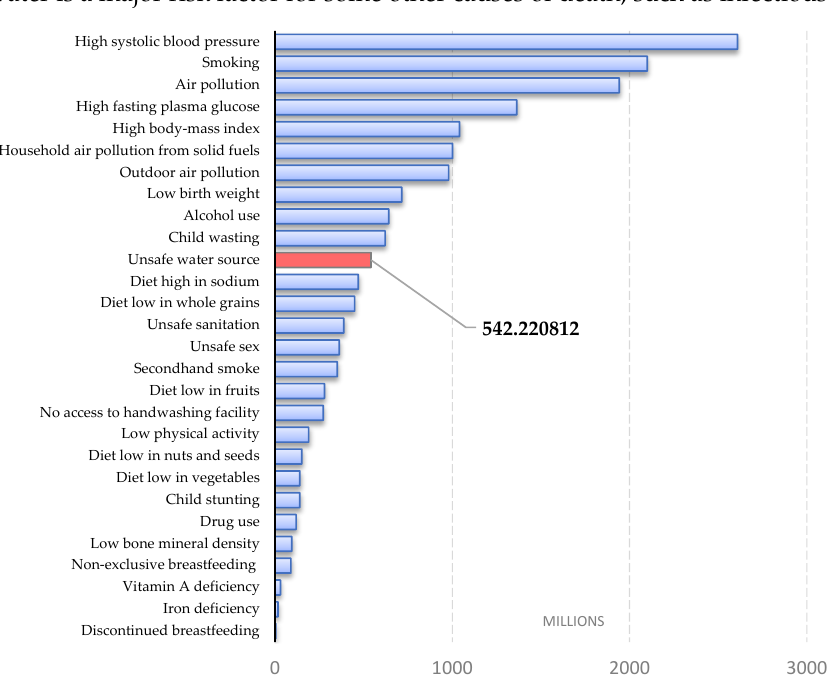
Figure 2. The relation between SDGs and maintaining drinking water quality [16–19]. Threats concerning water quality are divided into physical, chemical, and biological. Studies show that the damage caused by the last two cases is far more severe [20]. Indus- trial wastewater contains several toxic contaminants, such as pesticides, heavy metals, and pharmaceuticals. Among these pollutants, cyanide is one of the most dangerous chemical